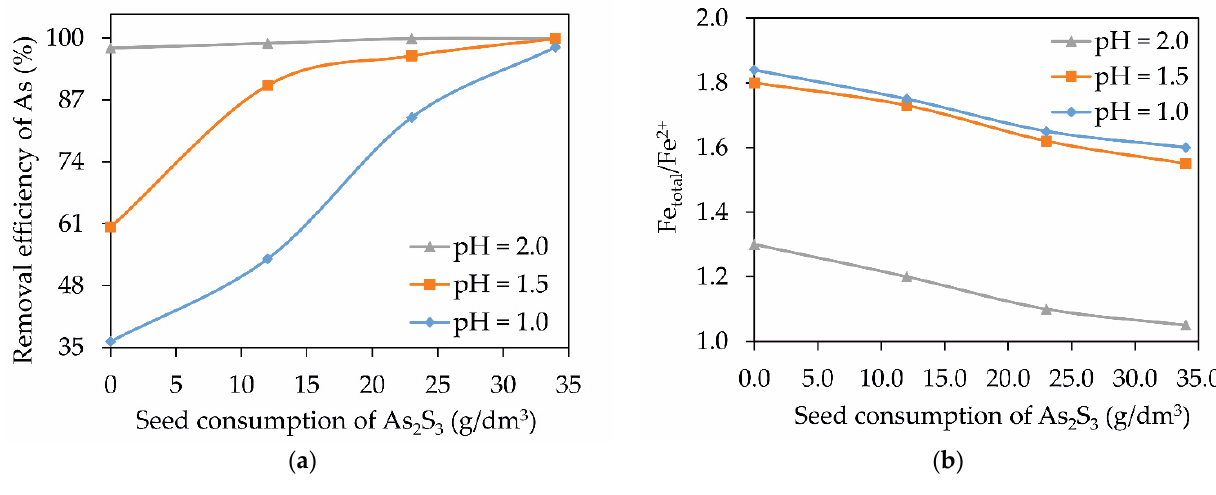
Figure 7. Dependence of the removal efficiency of arsenic (III) sulphide ( a ) and the ratio Fe total /Fe 2+ ( b ) in solution on seed crystal consumption at a molar NaHS/As consumption of 2.8 and a temperature of 25 ° С .